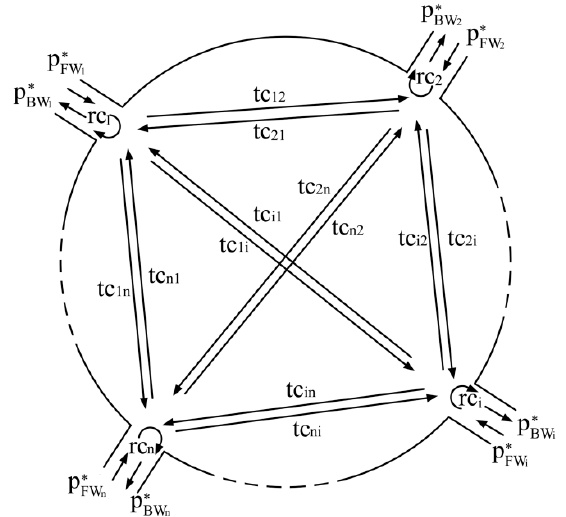
Figure 2. Schematic acoustic description of a multi-port configuration .